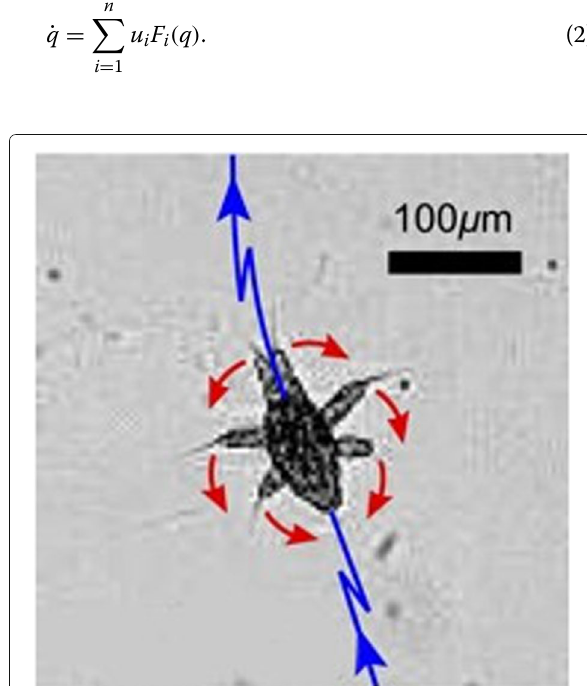
Fig. 1 Observation of a zooplankton